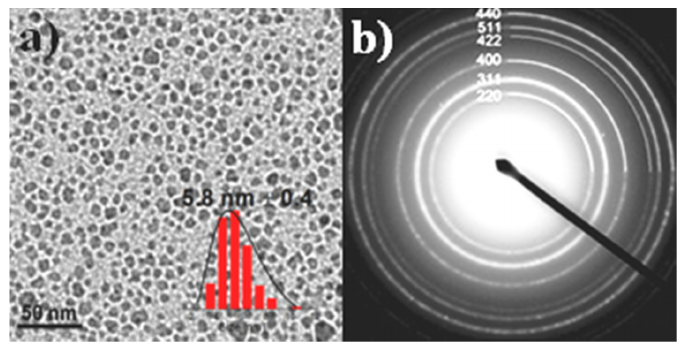
nanoparticles coated with octadecylamine (MNPs@ODA) and ( b ) the electron di ff raction pattern of the cobalt ferrite